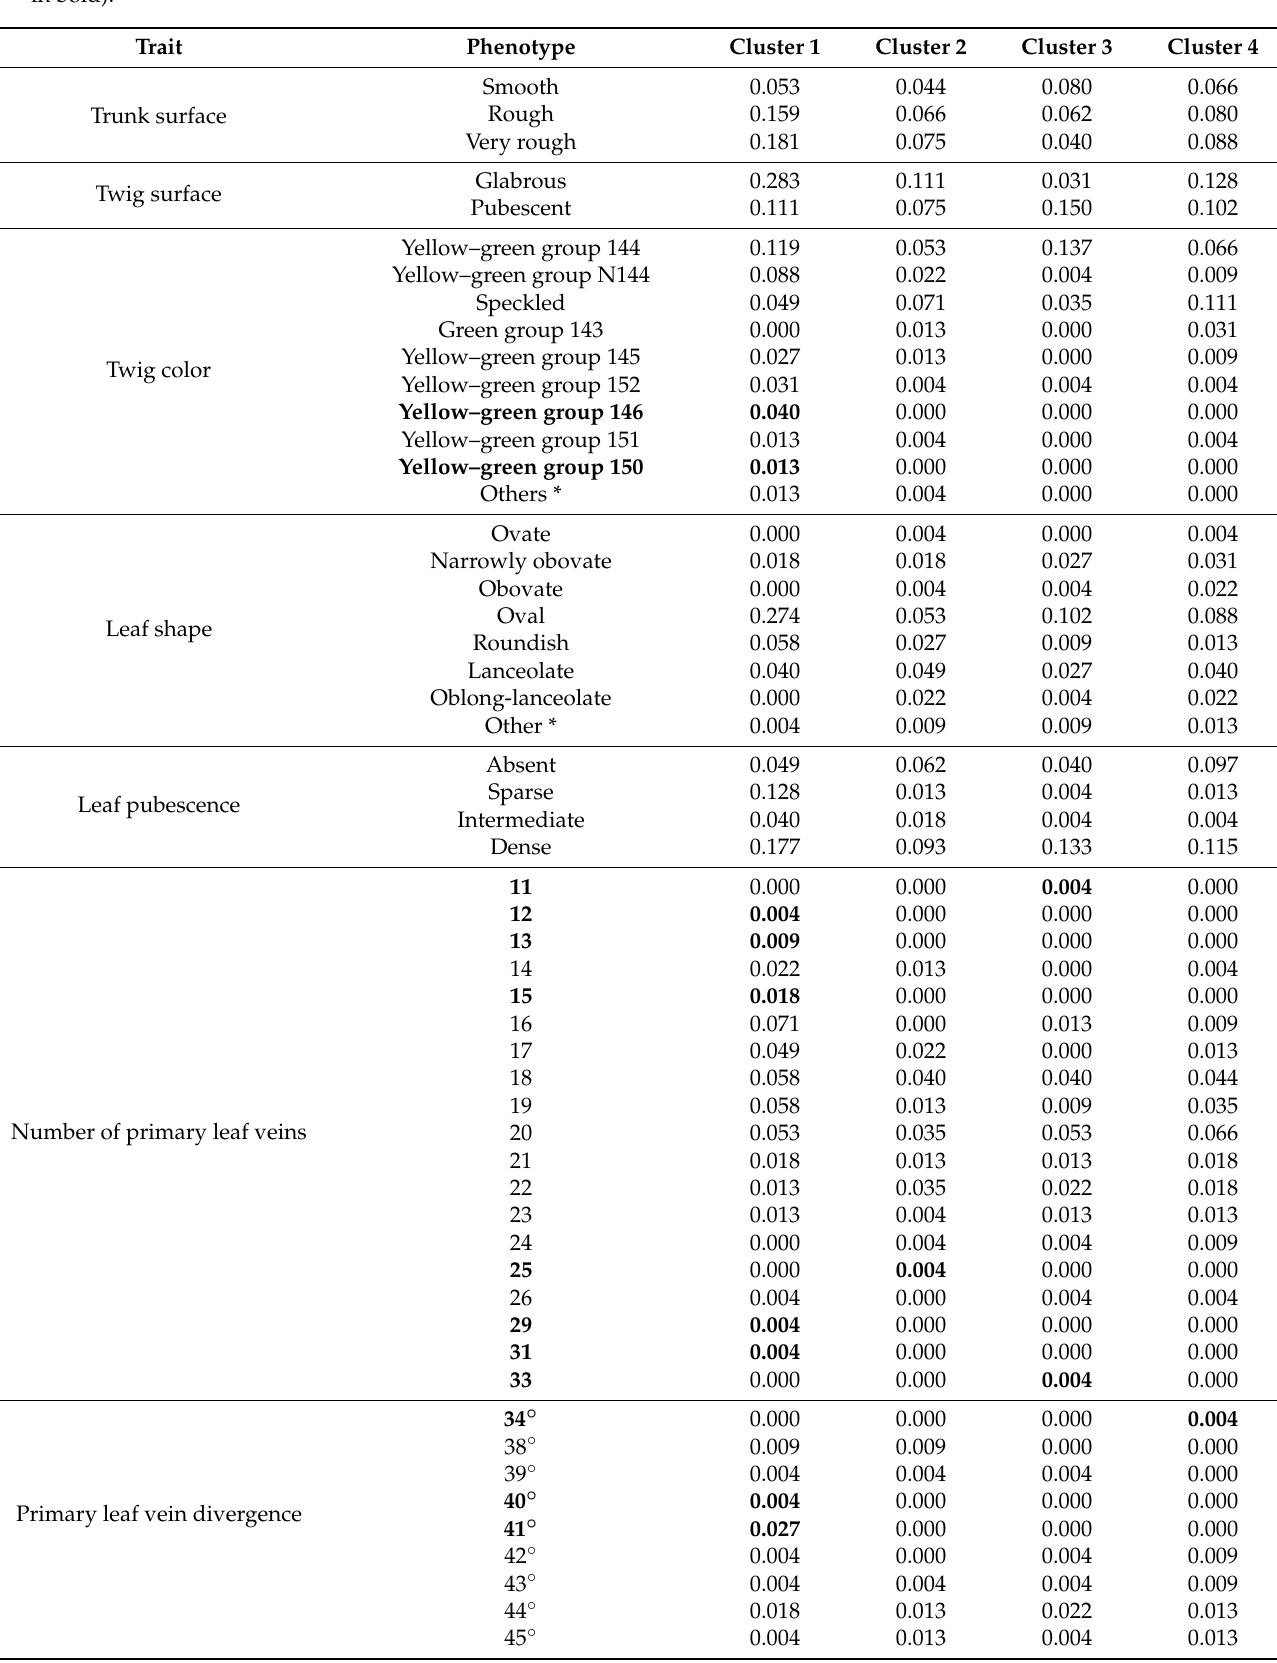
Table 7. Frequency distribution of different phenotypic characteristics across the four clusters (cluster-specific phenotypes in